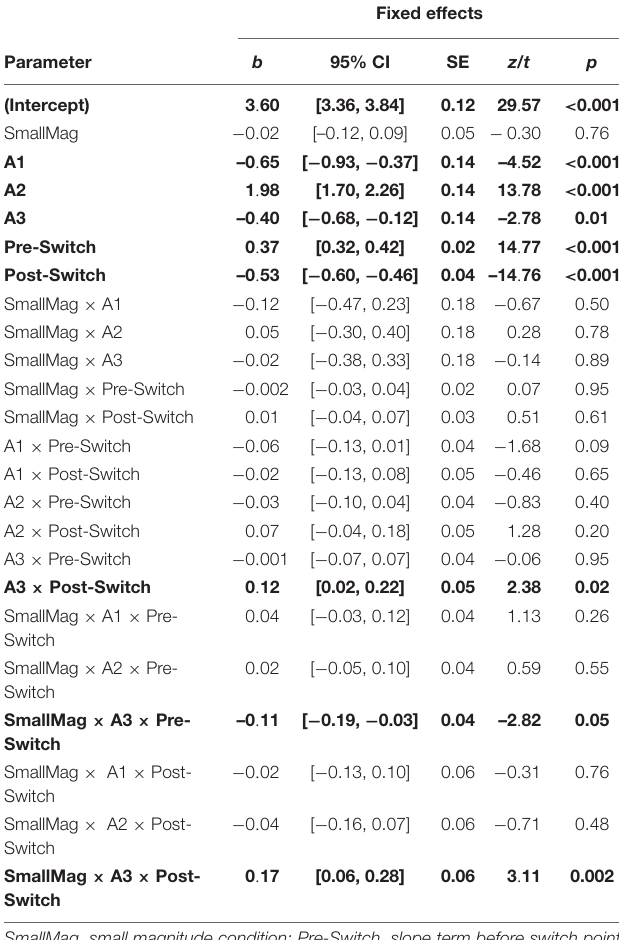
TABLE 2 | Parameter estimates of the dual-slopes linear mixed model of ambivalence